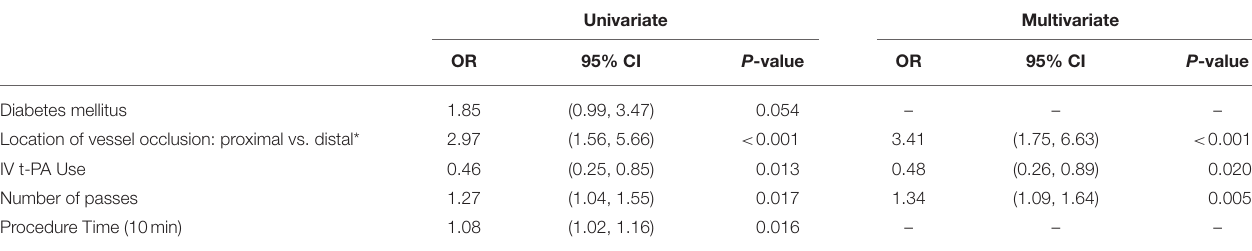
TABLE 3 | Predictors of post-thrombectomy SAH—multivariate logistic regression for anterior and posterior circulation vessel occlusions.